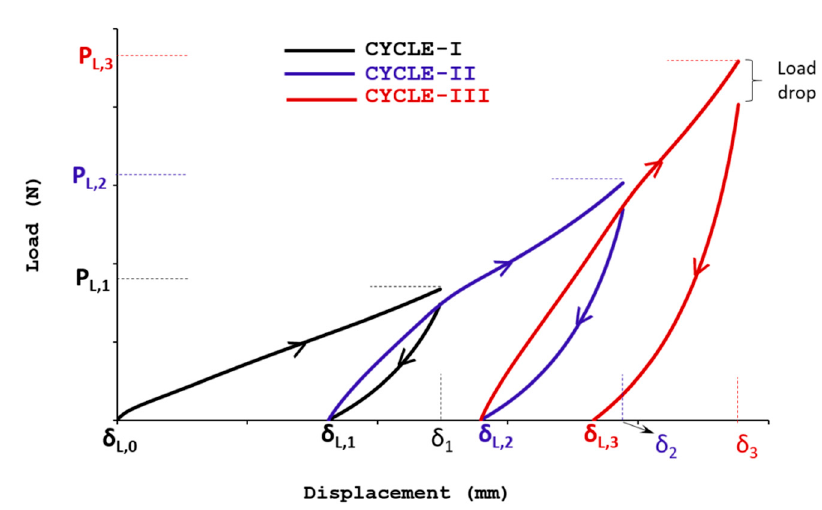
Figure 5. Schematic representation of cyclic compression loading/unloading test.